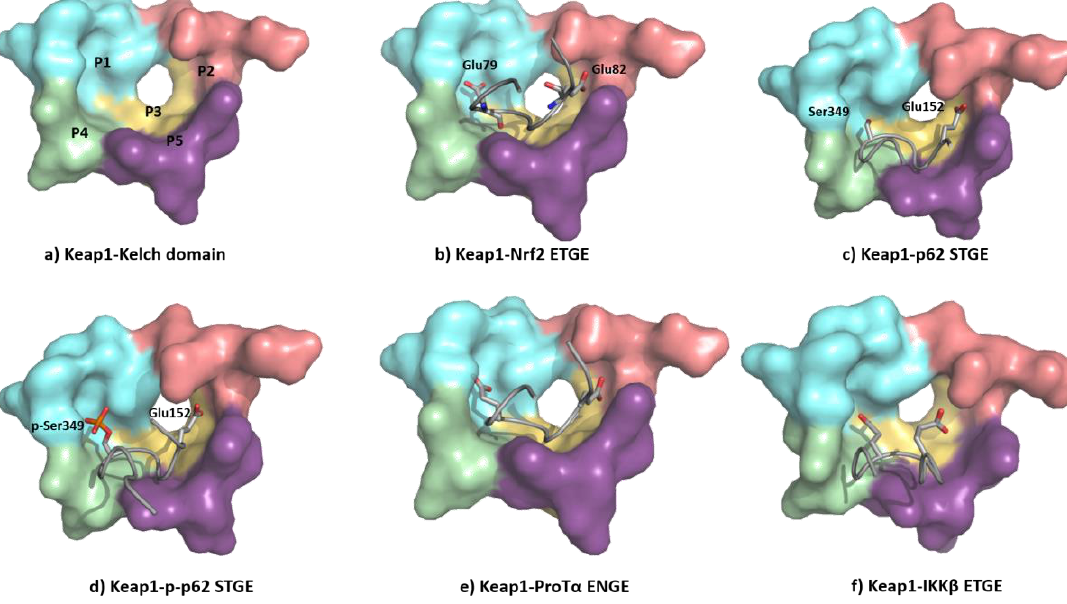
Figure 11. ( a ) Structure of the Kelch domain of KEAP1 (PDB: 5WTV), highlighting binding pockets P1: blue (residues 415, 461, 462, 478, 483 and 508); P2: red (363, 380, 381 and 414); P3: yellow (364, 509, 556, 571, 602 and 603); P4: green (334, 572 and 577); P5: purple (525, 530 and 555); ( b ) structural detail of the NRF2 ETGE motif bound to KEAP1 (PDB: 5WTV); ( c ) structural detail of the p62 STGE motif (PDB: 3ADE). The STGE motif in the KEAP1-interacting region (KIR) is similar to the ETGE-like motif of NRF2 and they both adopt similar β-turn conformations. However, while Glu79 in ETGE interacts with the Arg415 contained in the KEAP1 P1 subpocket, the corresponding Ser349 in STGE is too short, leading to a poor binding affinity; ( d ) structural detail of the Ser349-phosphorylated p62 STGE motif (PDB: 3WDZ). Phosphorylated Ser439 is deeply inserted into the P1 subpocket, and the negative charges increase the affinity through electrostatic interactions with Arg415 and Arg483; ( e ) structural detail of Protα ENGE motif (PDB 2Z32); ( f ) structural detail of the IKKβ ETGE motif obtained by molecular dynamics [149]. The substitution of the Thr residue (DEETGE, NRF2) by an Asn residue (NEENGE, ProTα) renders the β-turn conformation unstable, leading to a less potent binding between the ENGE motif and KEAP1 compared with that of the ETGE motif in NRF2. Small peptides based on structural similarity to KEAP1 substrates were the earliest examples of molecules designed to act as KEAP1 inhibitors [150]. However, they have several limitations, including their inability to cross the BBB and their poor stability. Thus, the development of small molecules as KEAP1 binding disruptors remains the main approach, overcoming the bioavailability and stability issues associated to peptides [151]. HTS of a library of more than 300,000 compounds led to tetrahydroisoquinoline 19 (Figure 12) as the first-in-class small-molecule KEAP1–NRF2 PPI inhibitor [151]. Further research efforts on this scaffold led to new structure–activity relationships [152]. The naphthalene sulfonamide derivative 20a (Figure 12) was also identified as a KEAP1–NRF2 inhibitor in a fluorescence anisotropy assay [153]. Structural determination showed an interaction between 20a and the P3–P5 subpockets in the Kelch domain of KEAP1. Based on this finding, compound 20b (Figure 12) was designed [153] with its two carboxyl groups forming multiple hydrogen bonds and electrostatic interactions with the basic Arg residues present in P1 and P2, thus improving the affinity with the KEAP1– NRF2 interface [153]. In the development process, the naphthalene core was replaced by an isoquinoline core to give 20c (Figure 12), improving the solubility, metabolic stability, and reducing the intrinsic toxicity of naphthalene scaffold [154]. Recently, the exploration of bioisosteric replacements of both carboxylic acids afforded the ditetrazole analogue 20d (Figure